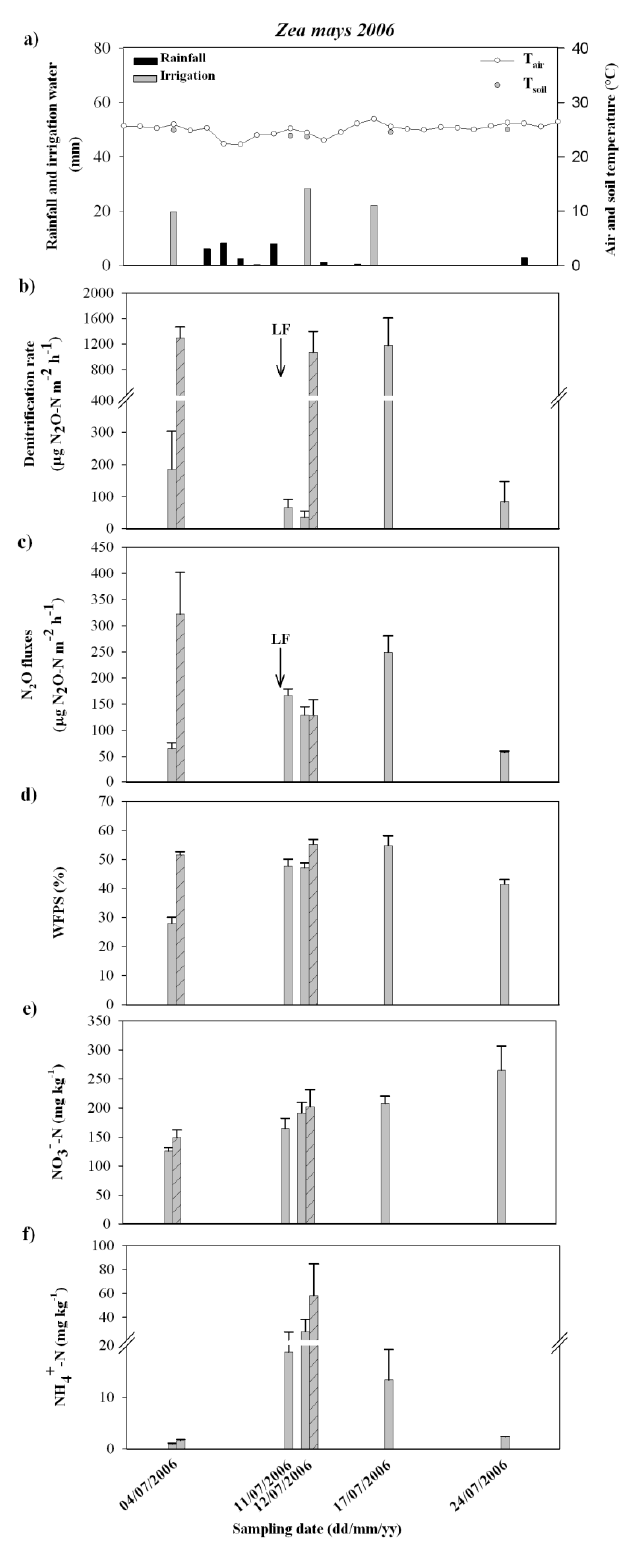
Figure 2. Figure shows: the pattern of climatic variables (daily average air temperature and rainfall, soil temperature and irrigation water input) ( a ) and the mean values and standard errors for denitrification rate ( b ), N 2 O fluxes ( c ), soil WFPS ( d ), soil NO 3 − ( e ) and soil NH 4 + ( f ), at the late fertilization (LF) in the course of the Zea mays crop in 2006.